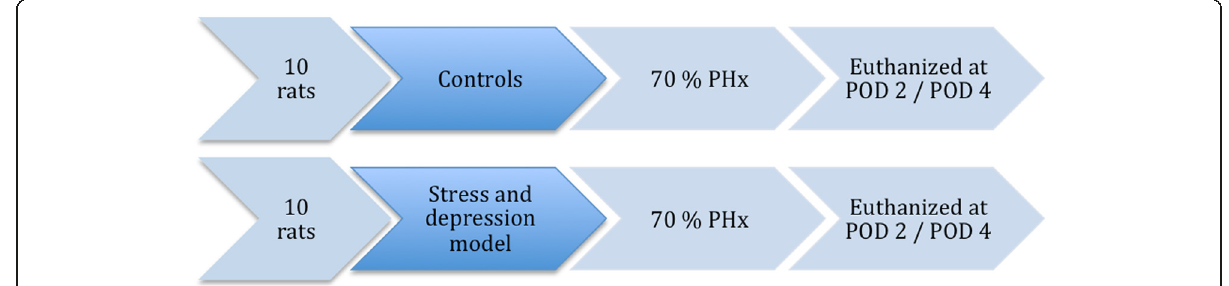
Fig. 1 Flowchart. The flowchart of the